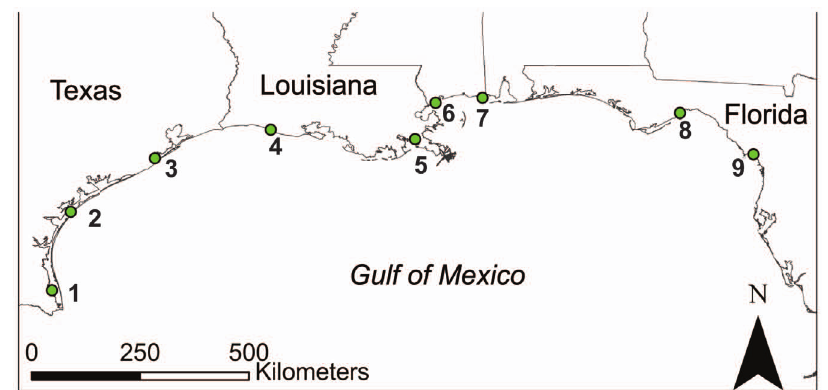
Figure 1. Map of sampling locations along the Gulf of Mexico. See Table 1 for details.